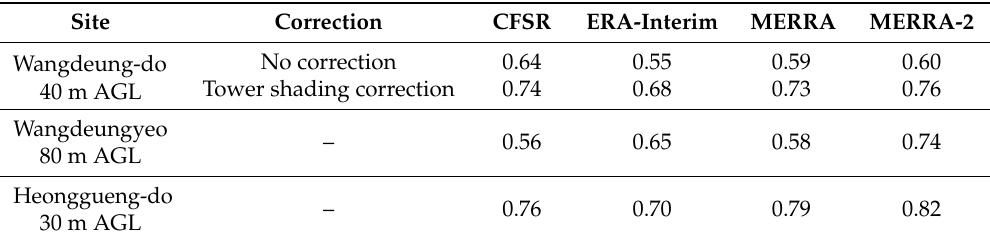
Table 7. Comparison between island measurements and reanalysis data ( R 2 ). Site